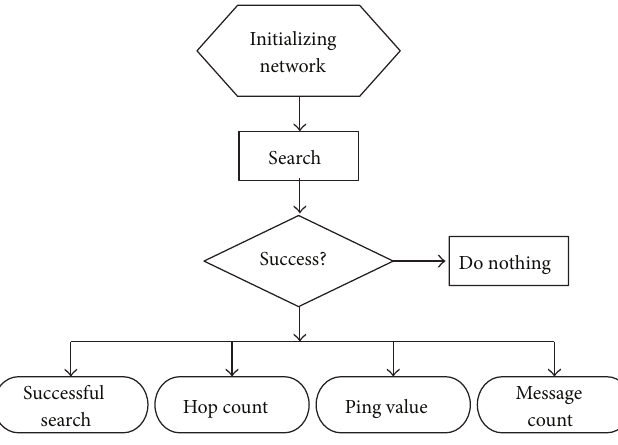
Figure 5: Simulation